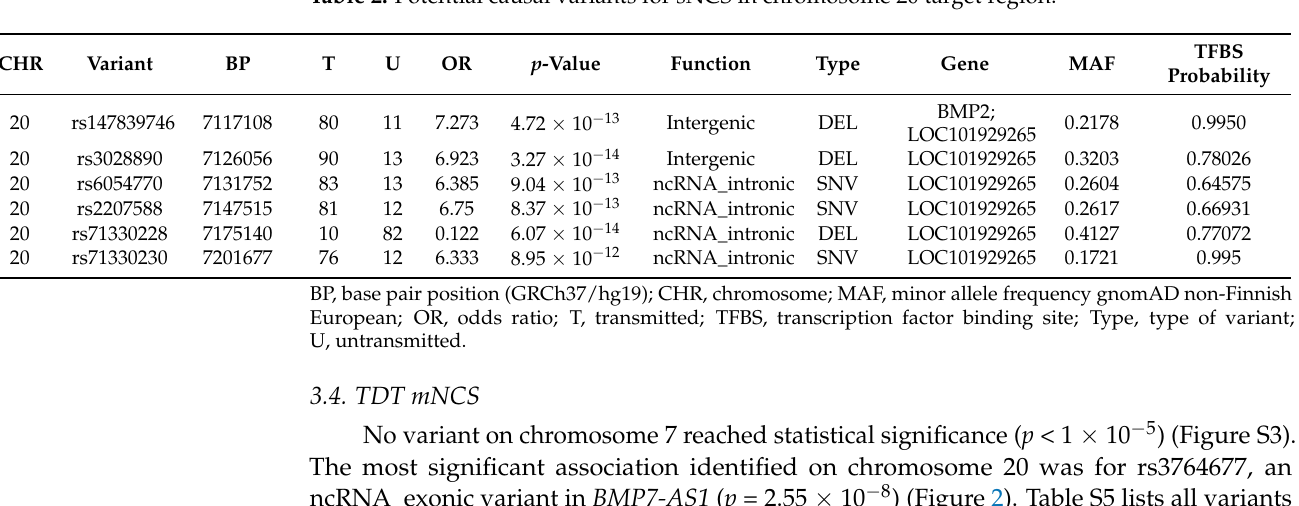
Figure 1. The results of the TDT using the sagittal suture phenotype from chromosome 20 using all 83 trios. The straight line at 7.3 and dashed line at 5 represents the genome-wide significant and genome-wide suggestive thresholds of 5.0 × 10 − 8 and 1.0 × 10 − 5 respectively. The LD ( r 2 ) between the top associated SNV rs1124471 ( p = 5.27 × 10 − 16 ) and other SNVs are indicated. A grey dot indicates lack of LD between variant and top associated SNP. The location of rs1884302, the most significantly associated SNV from the sNCS GWAS, is indicated with an arrow. GWAS, genome-wide asso- Table 2. Potential causal variants for sNCS in chromosome 20 target